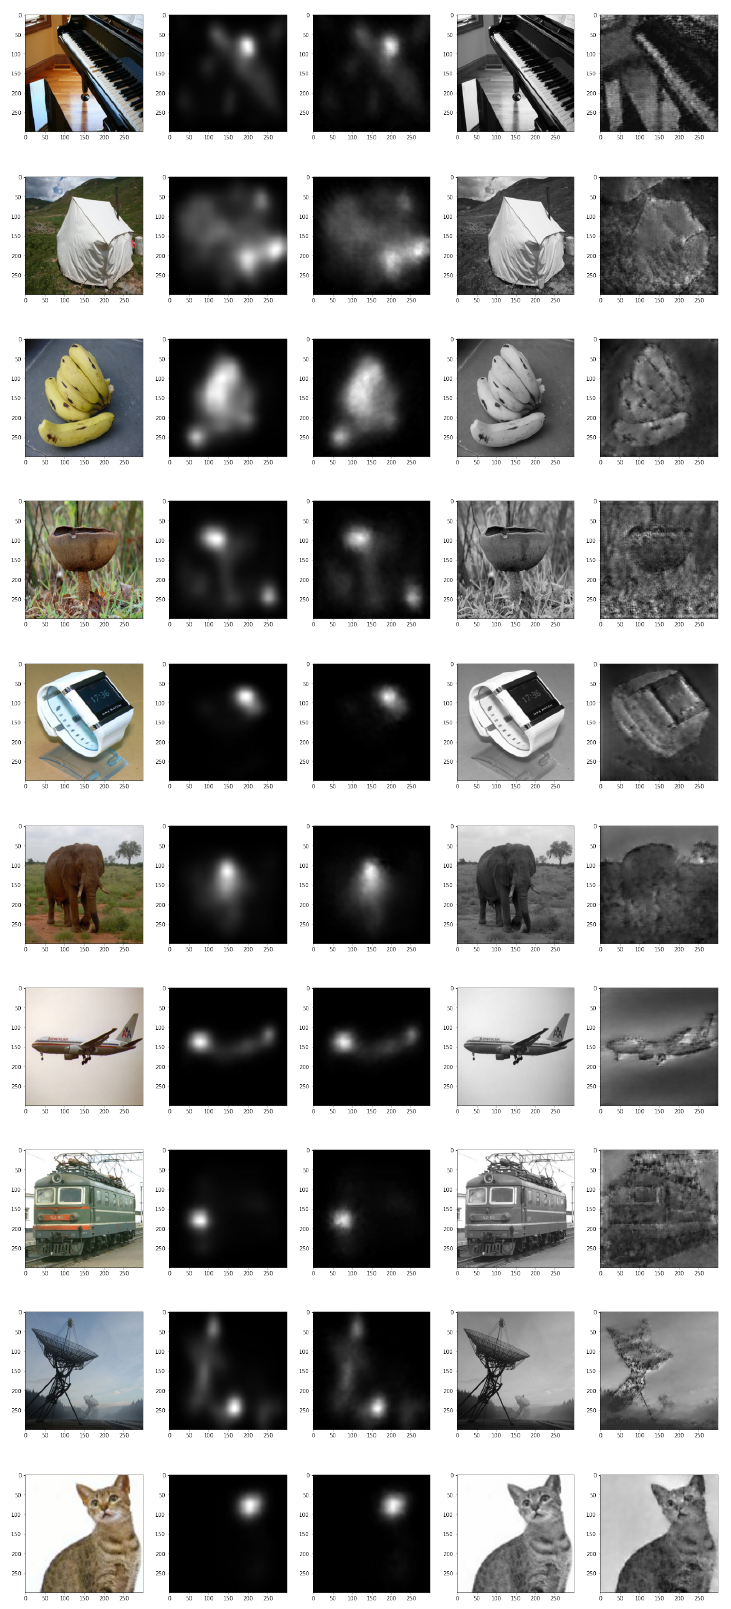
Figure 19. Reconstructed saliency and gray-scale images for categories 31–40; from ( left ) to ( right ): image used as stimulation, fixation map, EEG-based reconstructed saliency map, gray-scale image, EEG-based reconstructed gray-scale